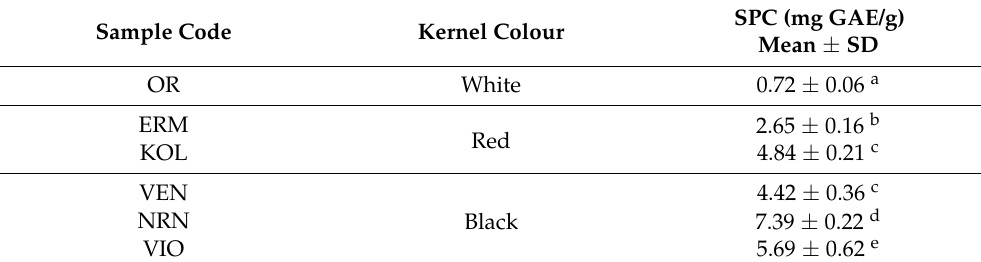
Table 2. Soluble phenolic content (SPC) of rice